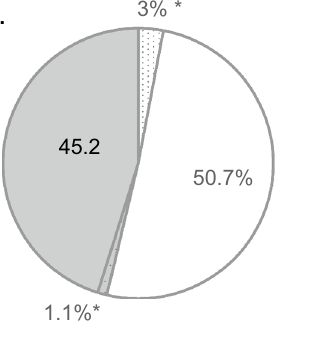
(Supplementary Fig. S3). Next, to assess the efficacy of antimicrobial interventions on controlling clb + E. coli on beef carcass surfaces, an inoculum pool of 4 clb + isolates and the reference E. coli O157:H7 FSIS-4 isolate was inoculated on beef flank (cutaneous trunci muscle) surfaces and treated in the USMARC pilot processing plant. The inoculated flanks were exposed to antimicrobial interventions and log reductions in Colony forming unit (CFU) per cm 2 were calculated. clb + isolates inoculated on the beef flank surfaces were found to be equally susceptible to LA, PAA, and BR with Log reductions of 0.7–1.3, 0.6–1.0, and 0.4 ± 1.0 CFU/cm 2 respectively. Dry steam was found to be most effective at reducing clb + E. coli on beef flank surfaces (1.6–2.8 2 Log CFU/cm 2 reduction) (Fig. 3). There were no statistically significant differences between clb + E. coli and the reference E. coli O157:H7 FSIS-4 (log